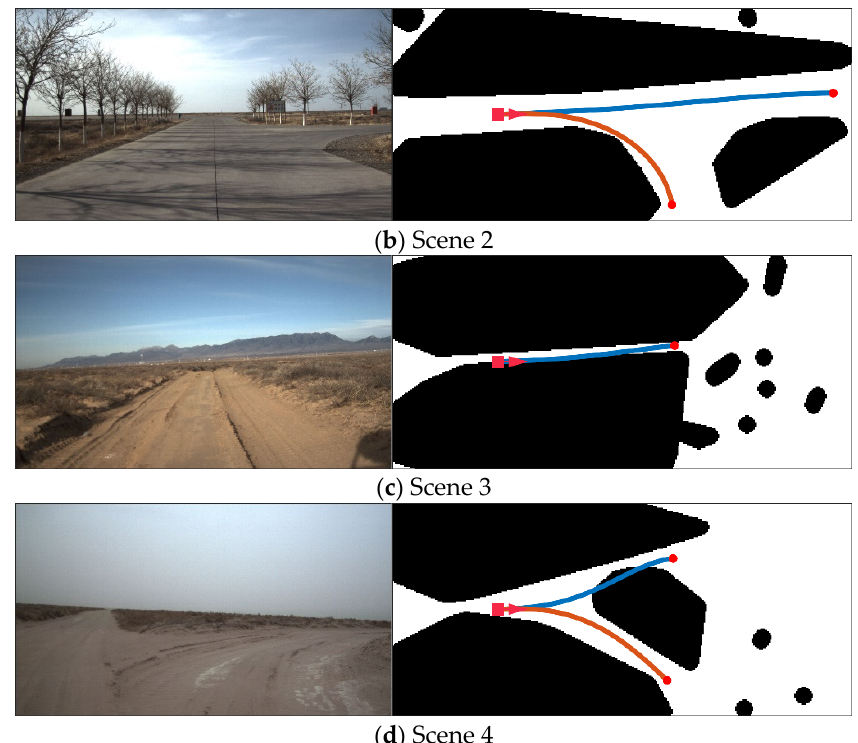
Figure 22. The trajectory curves satisfying the differential constraint of motion in different scenes.